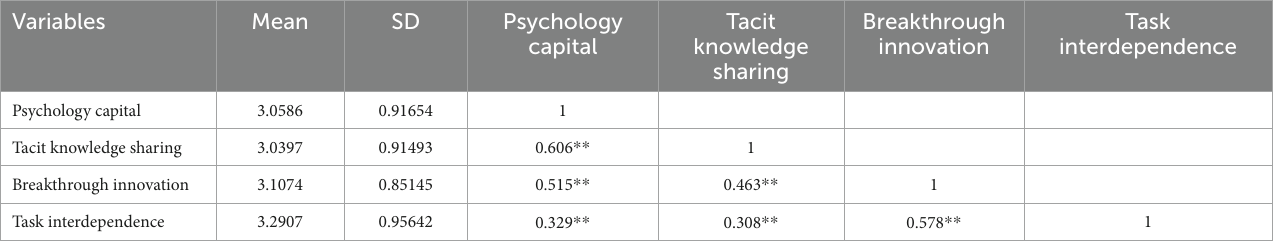
FIGURE 1 Research framework.